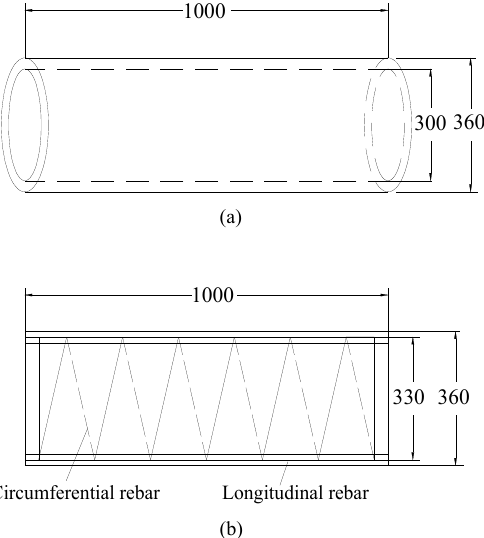
Figure 5. Specimen dimensions: ( a ) concrete; ( b ) rebars (mm).